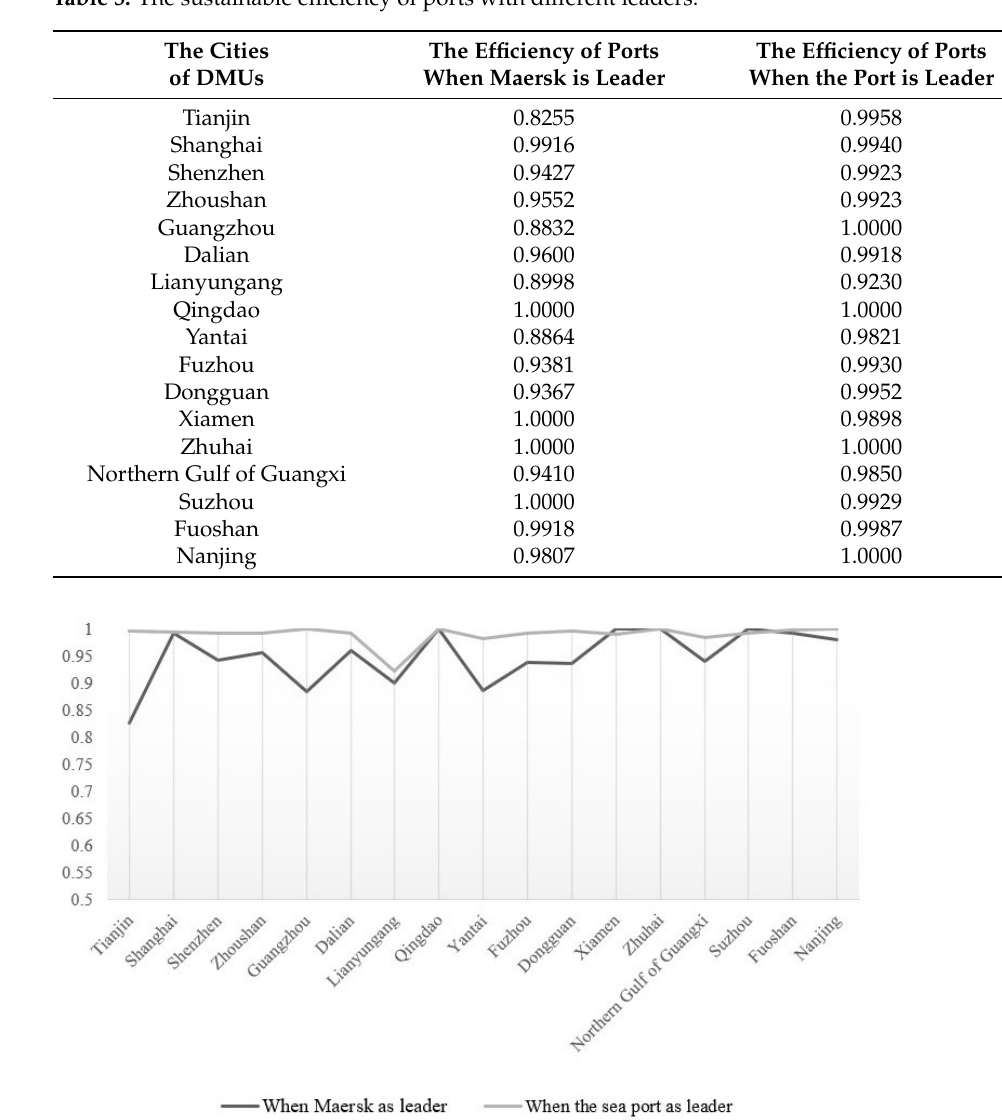
Table 5. The sustainable efficiency of ports with different leaders.